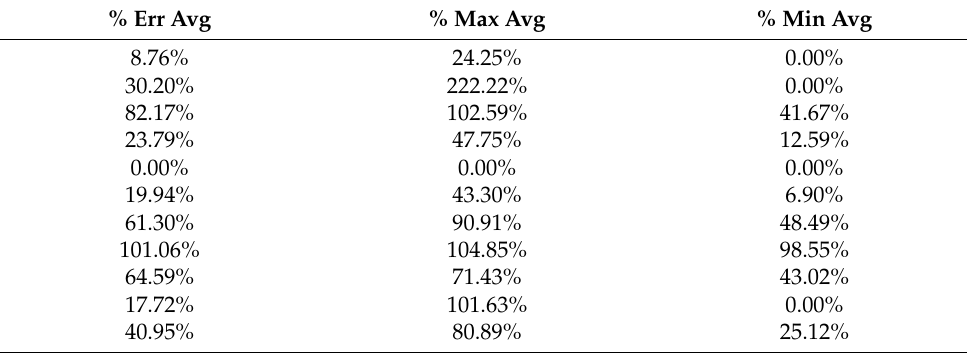
Table A194. Set 3, trials 21–30 data (single 0.5 PR value).